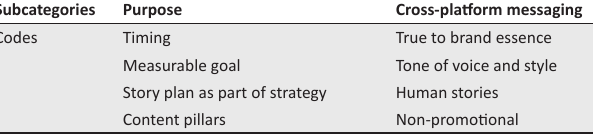
TABLE 3: Category 2: Platform-specific content. Subcategories